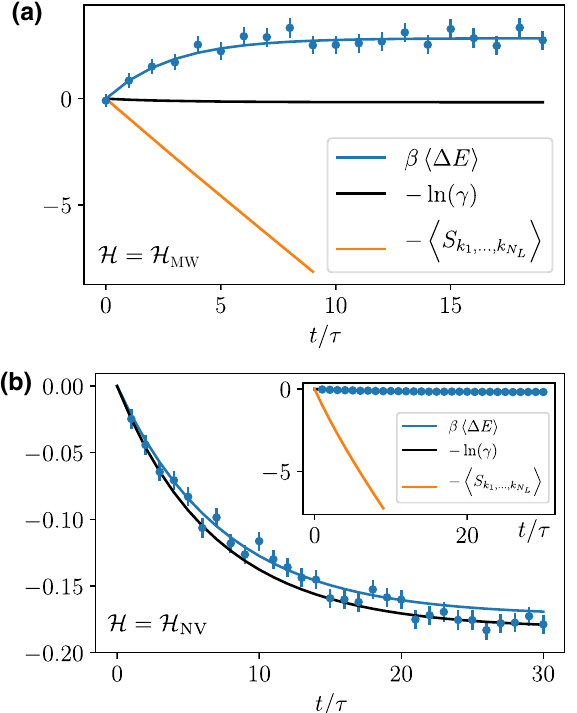
FIG. 4. Experimental values of β (cid:3) (cid:3) E (cid:2) as a function of the number of laser pulses for a 3LS with Hamiltonian operators H H β (cid:3) (cid:3) E (cid:2) (with β > 0) MW (a) and NV (b). Negative values of may allow energy extraction from the 3LS. The solid blue line corresponds to the values of β (cid:3) (cid:3) E (cid:2) as predicted by theory, while (cid:2) are denoted by the theoretical bounds − ln γ and −(cid:3) S k 1 , ... , k NL solid black and orange lines, respectively. The inset in (b) shows at the same time the tightness of − ln γ and the discrepancy (cid:2) , both with respect to the mean energy variation of −(cid:3) S k 1 , ... , k NL β (cid:3) (cid:3) E (cid:2)